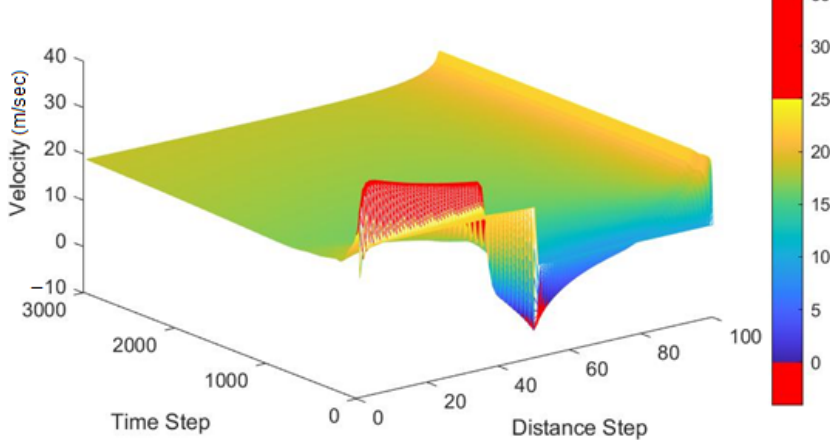
Appl. Sci. 2021 , 11 , x FOR PEER REVIEW Figure 15. Velocity behavior of the PW model on a ring road. Figure 15. Velocity behavior of the PW model on a ring road.